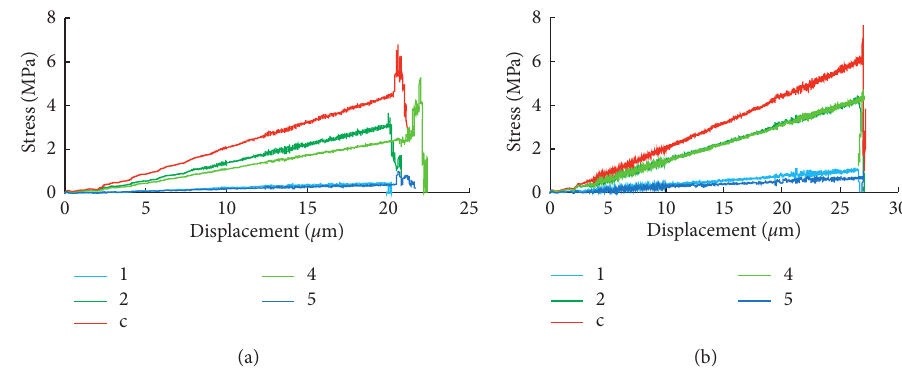
Figure 21: Loading stress-displacement curves of uniform parallel bedding models with different layer thicknesses. (a) 3.6 mm. (b) 5.0mm.